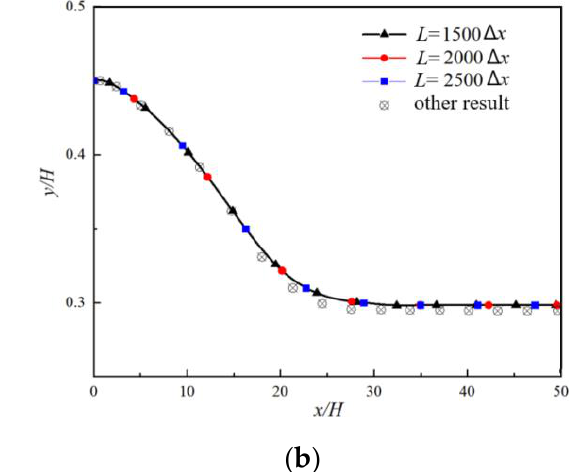
Figure 4. Comparison of results of particle trajectories for different H and D ( a ) and L ( b ).